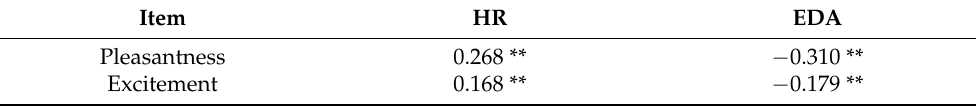
Table 6. SD scores for different types of sounds.